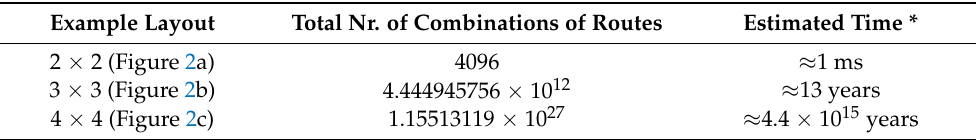
Figure 1. Input layout and the corresponding occupancy grid: ( a ) layout with pick-up/drop-off locations (yellow circles), white represents the driving area and black are the walls or other static obstacles; ( b ) the corresponding occupancy grid with the reinforcement-learning agent searching for the routes between pick-up and drop-off locations (the light blue arrows around the agent illustrate four possible actions). Table 1. The total number of different combinations of routes (middle column), and estimated time to find all combinations and to calculate the optimization function values for all combinations of routes (right column).